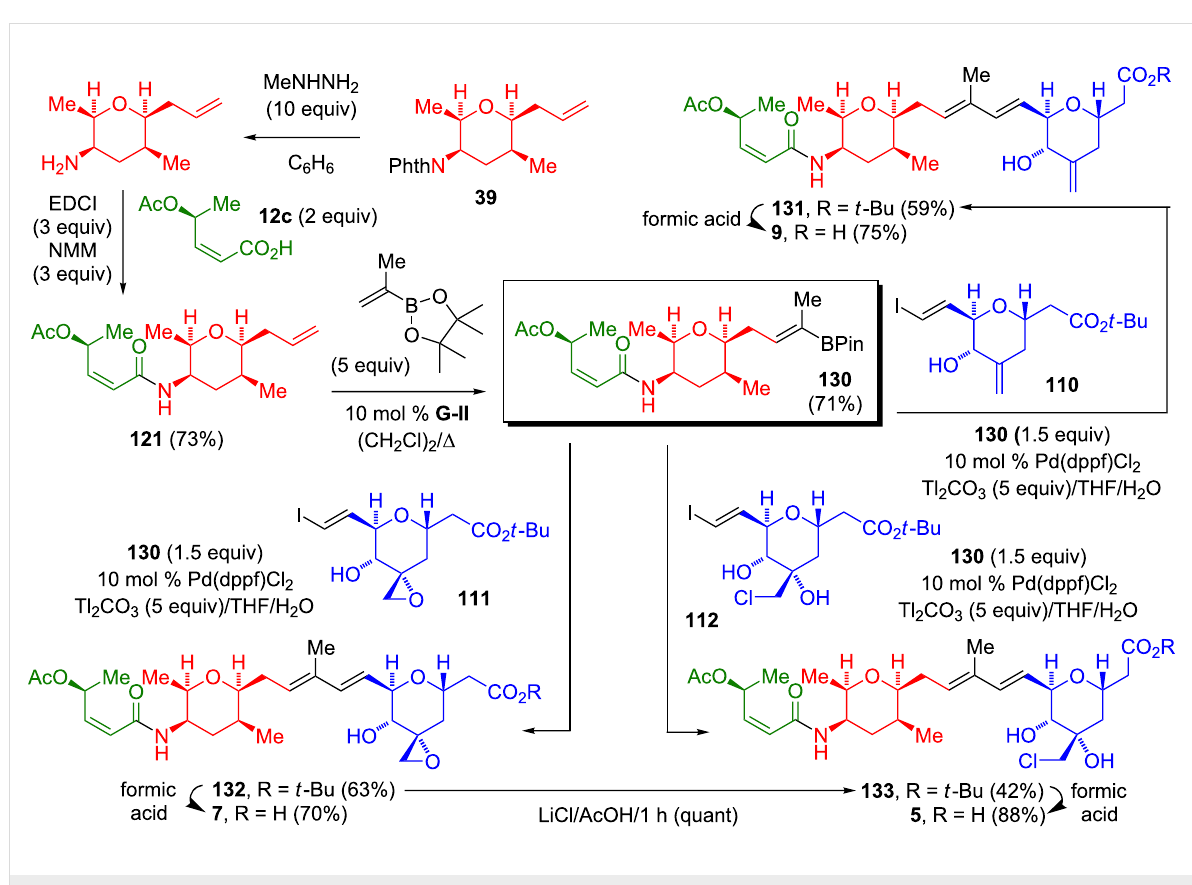
Scheme 24: Nicolaou syntheses of thailanstatin A and B ( 7 and 5 ) and spliceostatin D ( 9 ) via a Pd-catalyzed Suzuki–Miyaura